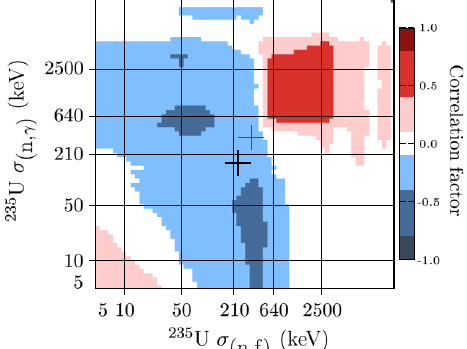
Fig. 6. As in Figure 4: correlation sub-matrix between the fi ssion cross section of 235 U and the capture cross section of 238 U. The cross indicate the average energy of the neutron causing 235 U fi ssion and 238 U capture events.